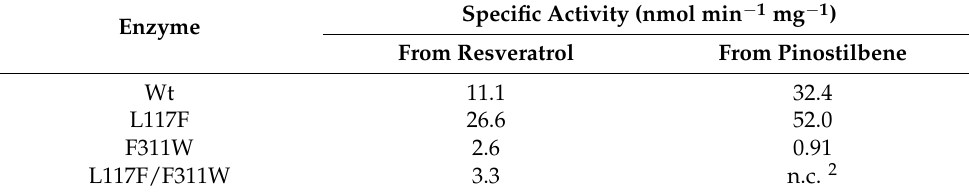
Table 2. Specific activity of VvROMT variants 1